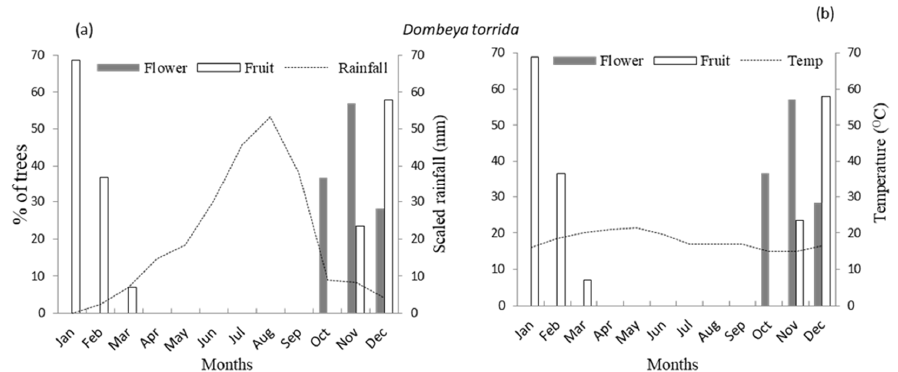
Figure 3. Percentage of flowering and fruiting of Brucea antidysenterica in relation to: ( a ) monthly precipitation ( b ) average temperature. In which Jan = January, Feb = February, Mar = March, Apr = April, May = May, Jun = June, Jul = July, Aug = August, Sep = September, Oct = October, Nov = November, Dec = December.